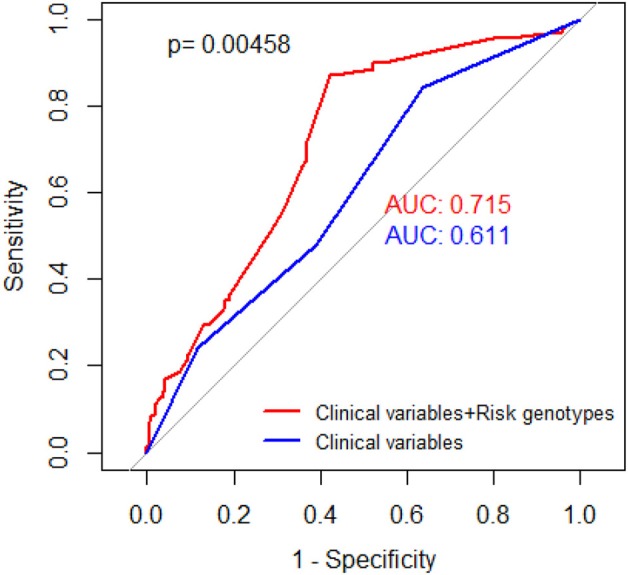
Receiver operating characteristic (ROC) curves. Red curve for prediction of HNSCC-specific survival rate based on selected SNPs and clinical stage, with adjustment of age, gender, smoking status, and drinking status (AUC = 0.715). Blue curve for prediction of HNSCC-specific survival rate based on clinical stage, with adjustment of age, gender, smoking status, drinking status (AUC = 0.611). P value was derived from DeLong's test for two correlated ROC curves.